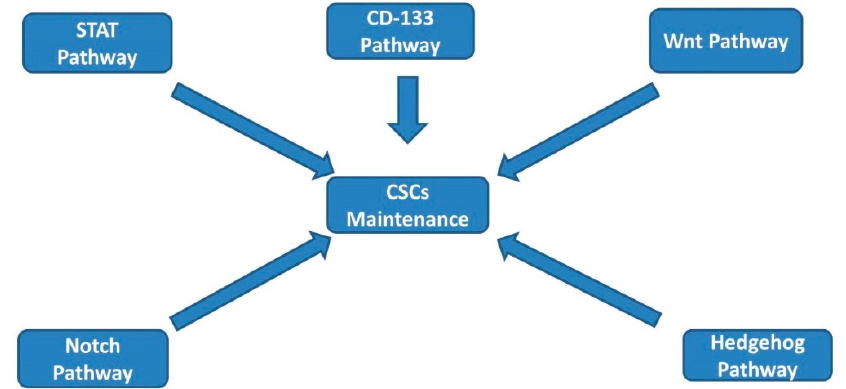
Figure 1. Selected signaling pathways involved in cancer stem cells maintenance. CSCs: cancer stem cells.